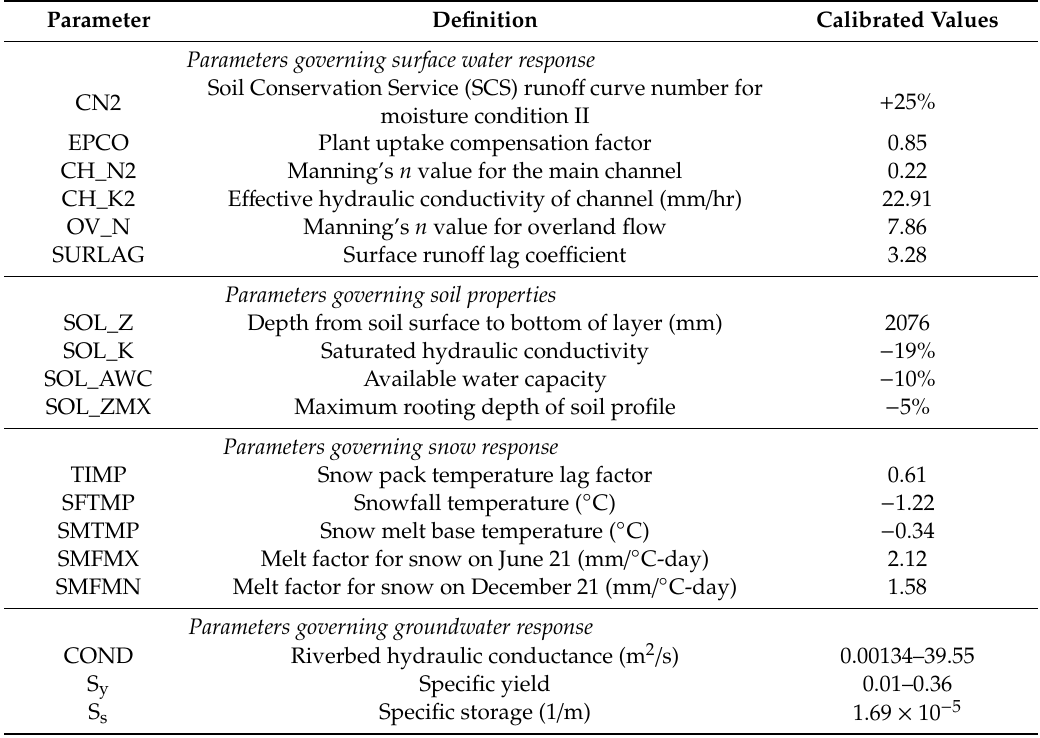
Table 1. List of parameters that produced for SWAT-MODFLOW